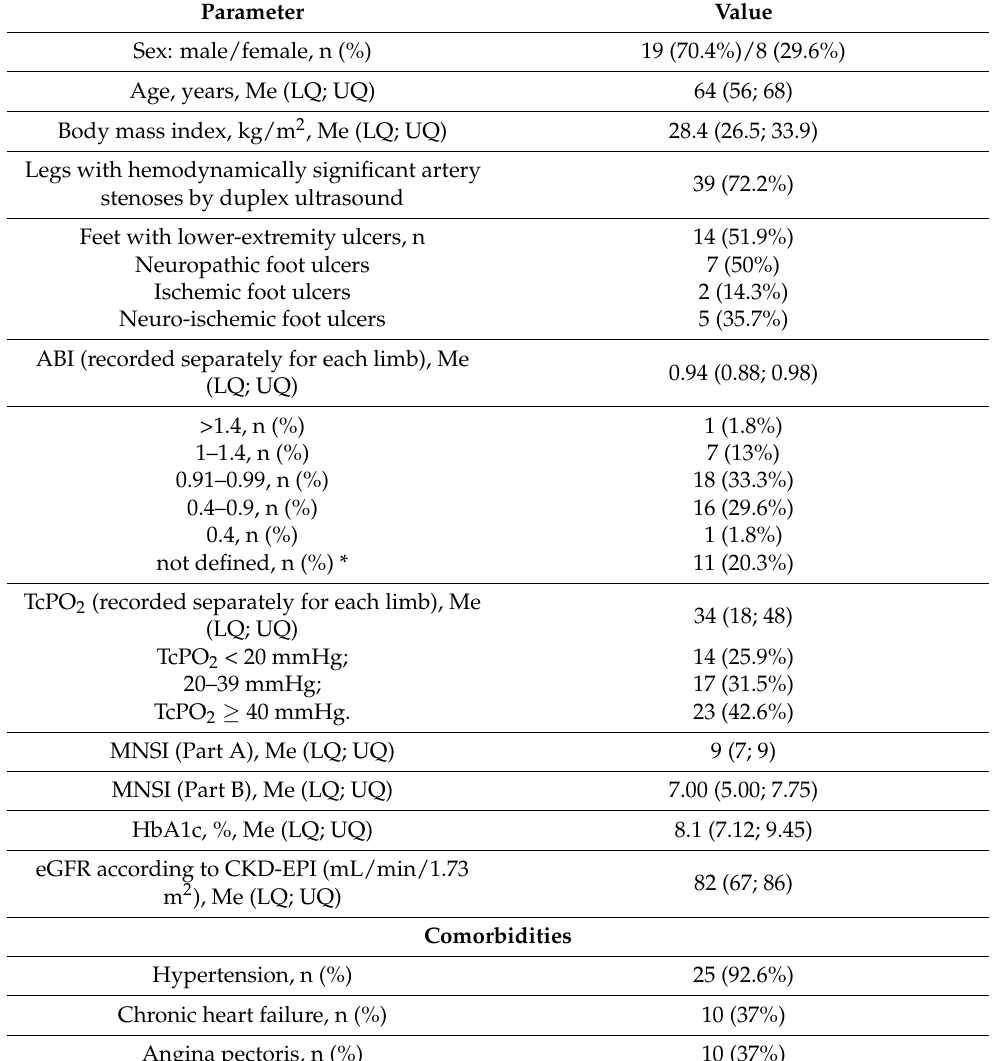
Table 1. Characteristics of the studied patients.